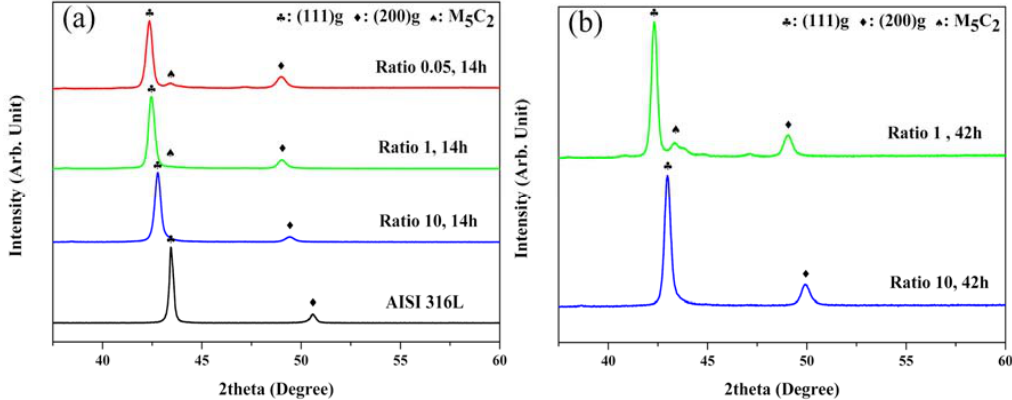
Figure 3. X-ray diffraction (XRD) patterns obtained from the ASS samples carburized for ( a ) 14 h and ( b ) 42 h.